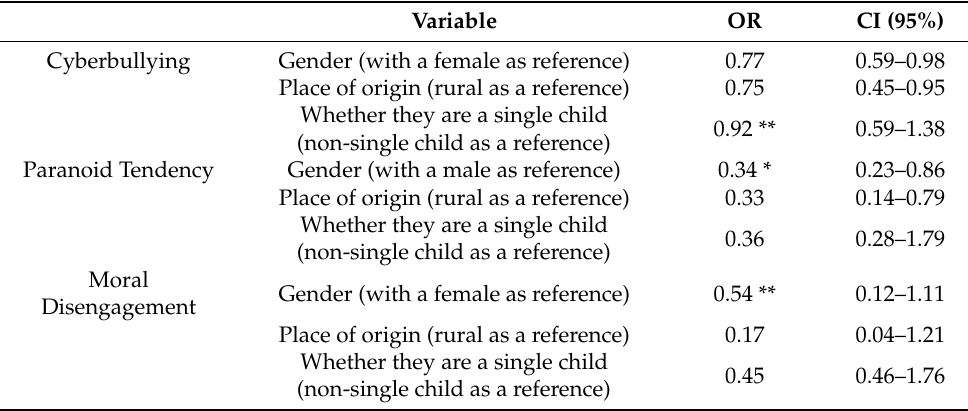
Table 1. Regression analysis of relevant variables.